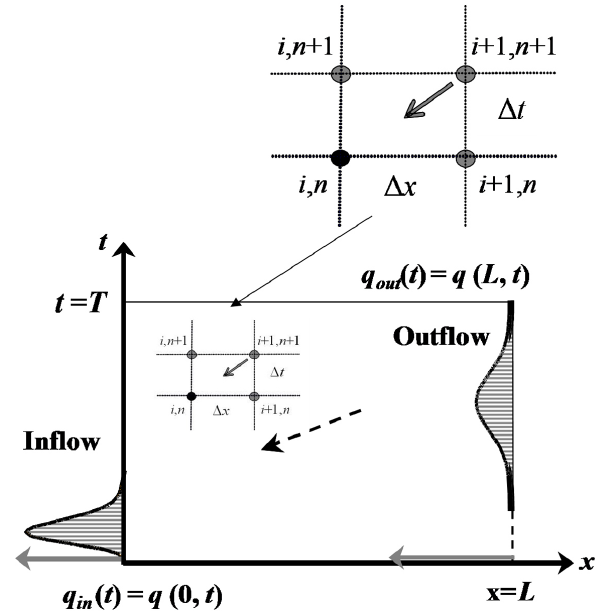
Fig. 1. Reverse flood routing in a stream reach of length L : q out (t) = q(L,t) observed outflow hydrograph, q in (t) = q( 0 ,t) in- flow hydrograph; −→ direction of reverse routing.